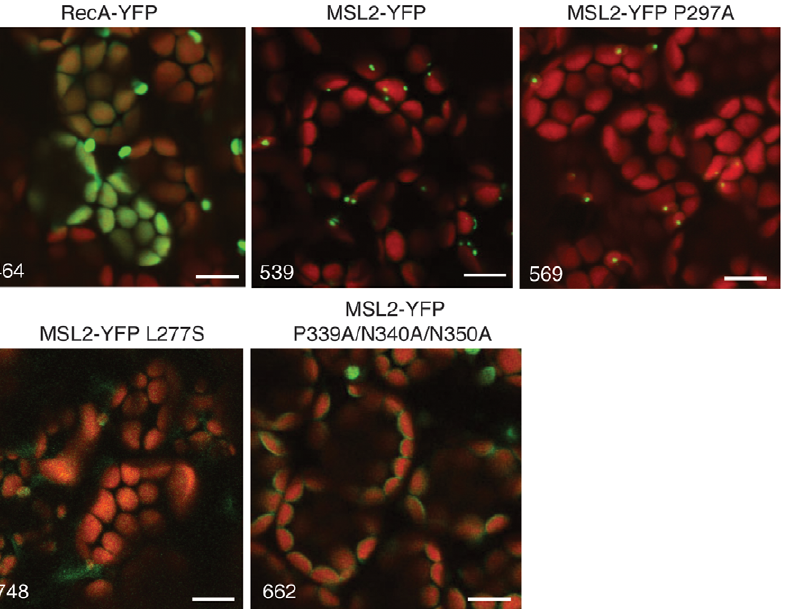
Figure 5. MSL2-YFP P339A/N340A/N350A shows aberrant intraplastidic localization. Representative confocal images of rosette leaves from T3 plants expressing the indicated transgenes, with the YFP channel voltage for each image shown in the lower left hand corner. The same region of the leaf was imaged as in Figure 3B. YFP signal is pseudo-colored green and chlorophyll is pseudo-colored red. Size bar is 10 microns.